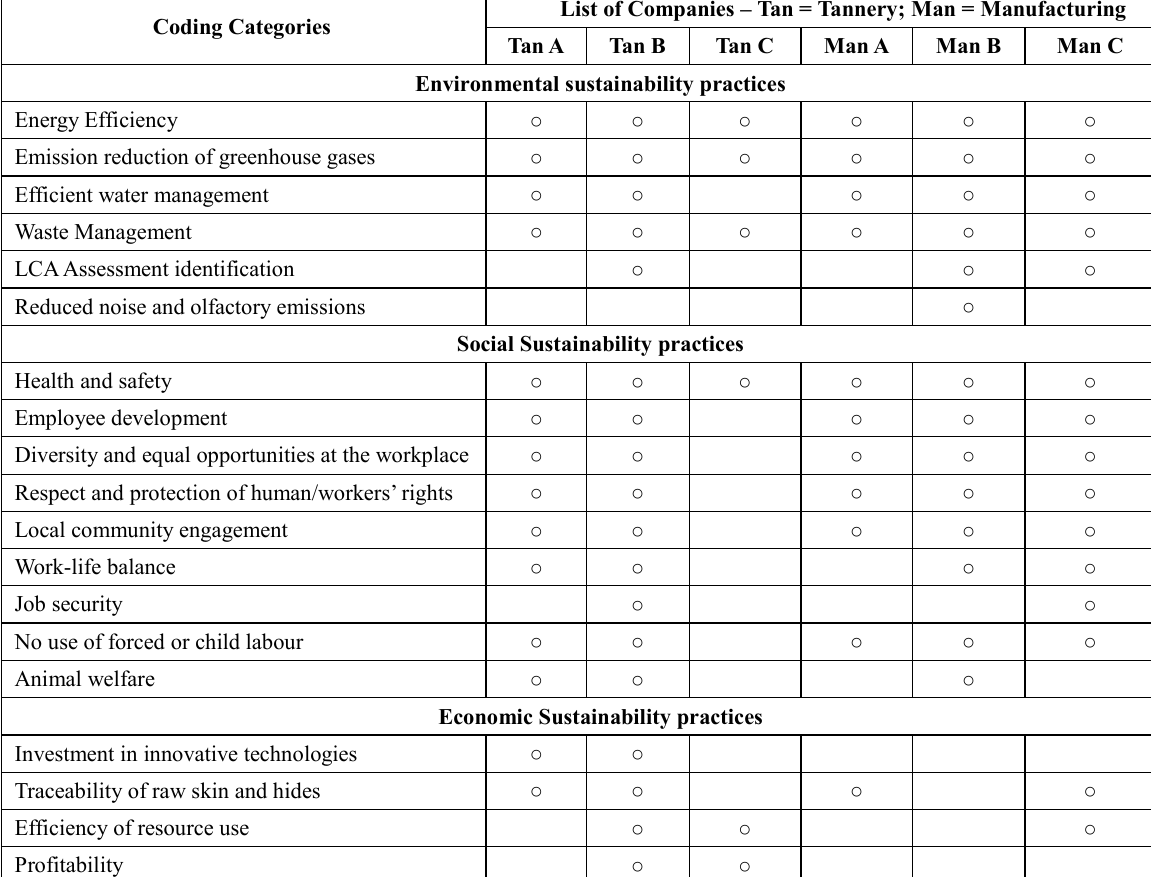
Table 3. Comparison of leather companies on practices relating to the sustainability dimensions Coding